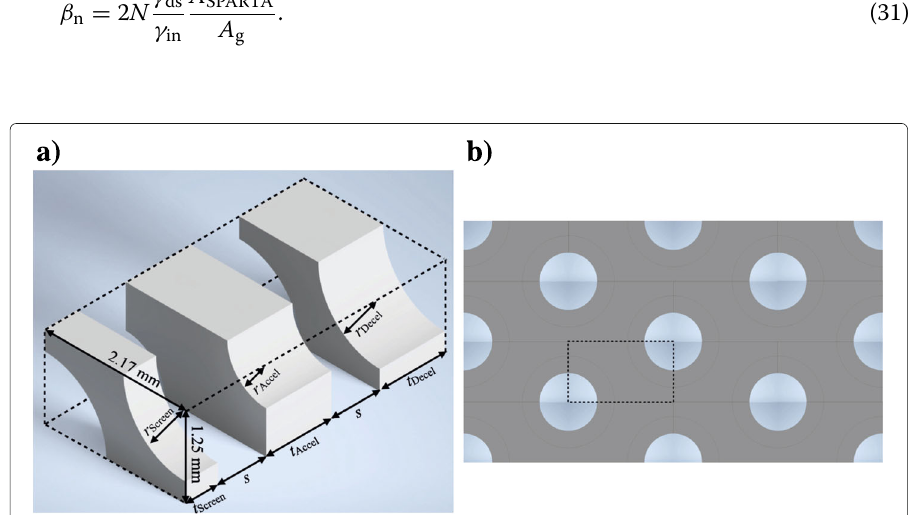
Fig. 5 Unit Cell simulation domain processed with SPARTA: a ) Oblique and b ) front